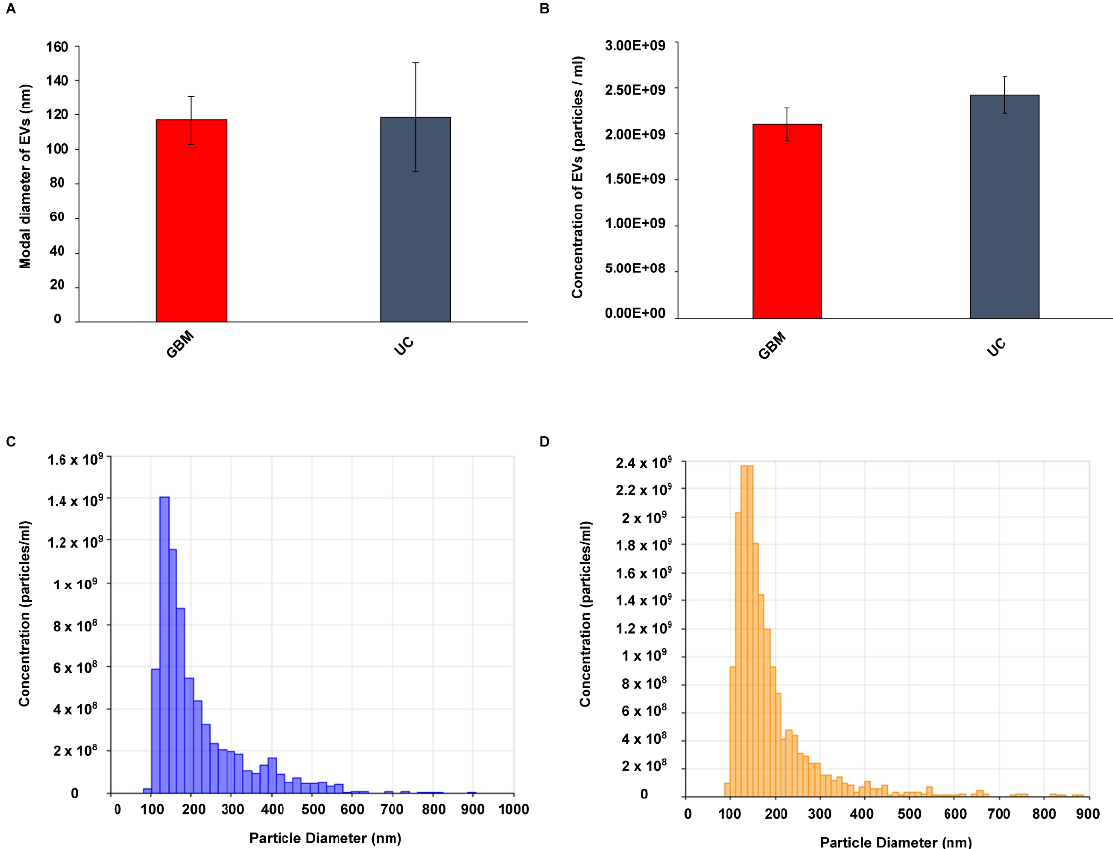
Figure 1. Bar graphs showing ( A ) modal diameter (nm) and ( B ) concentration (particles/mL) of sEVs isolated from GBM and UC. Data are represented as mean ± SEM of the measurements performed by tunable resistive pulse sensing (TRPS) on three randomly chosen GBM and control samples. Plots showing concentration (particles/mL, y-axis) and size (nm) distribution (x-axis) of sEVs isolated from a representative UC and GBM sample are shown in ( C , D ), respectively.